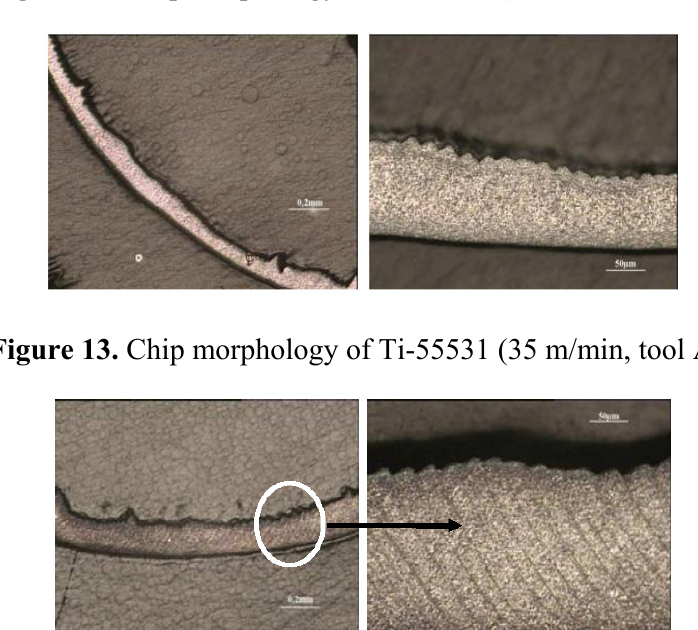
Figure 12. Chip morphology of Ti-55531 (20 m/min, tool A).